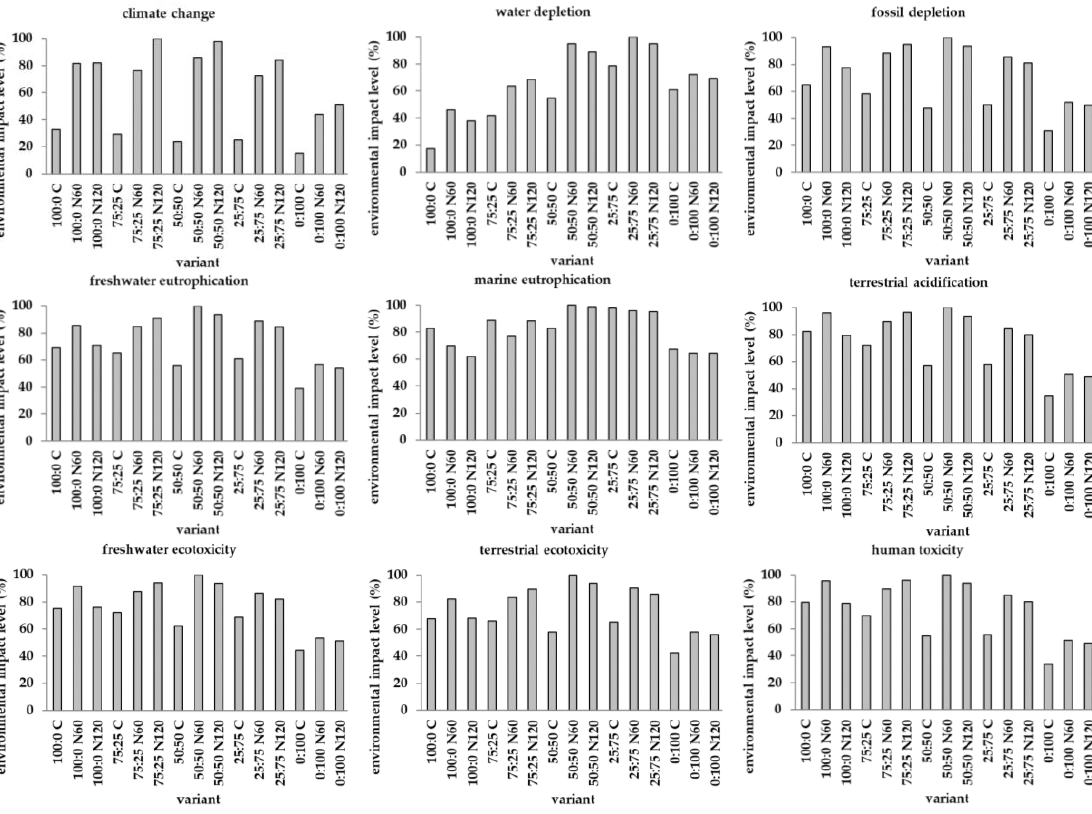
Figure 3. Trends of the environmental impact per land demand for generating the same grain N yield–(in %); C = Control; N60 = variant with input of 60 kg N ha −1 ; N120 = variant with input of 120 kg N ha −1 ; Sowing ratios of oat:pea (%:%): 100:0, 75:25, 50:50, 25:75, and 0:100; SimaPro 9.1.1.1 software; ReCiPe 2016 Midpoint (H) V1.05/World (2010) H; Cut-off System Model approach; Characterization model .